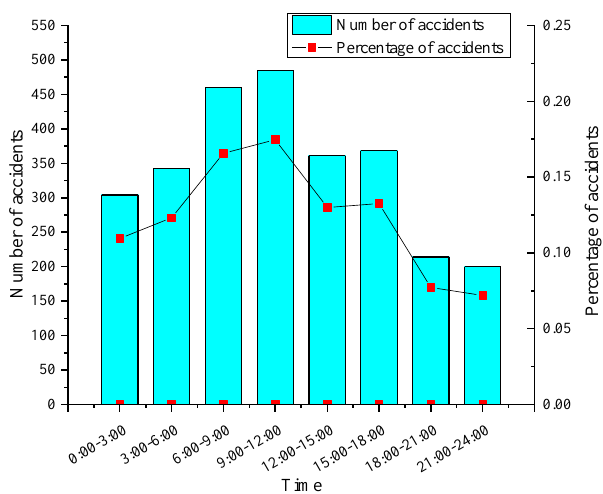
Figure 3. Distribution of accidents by time of day.